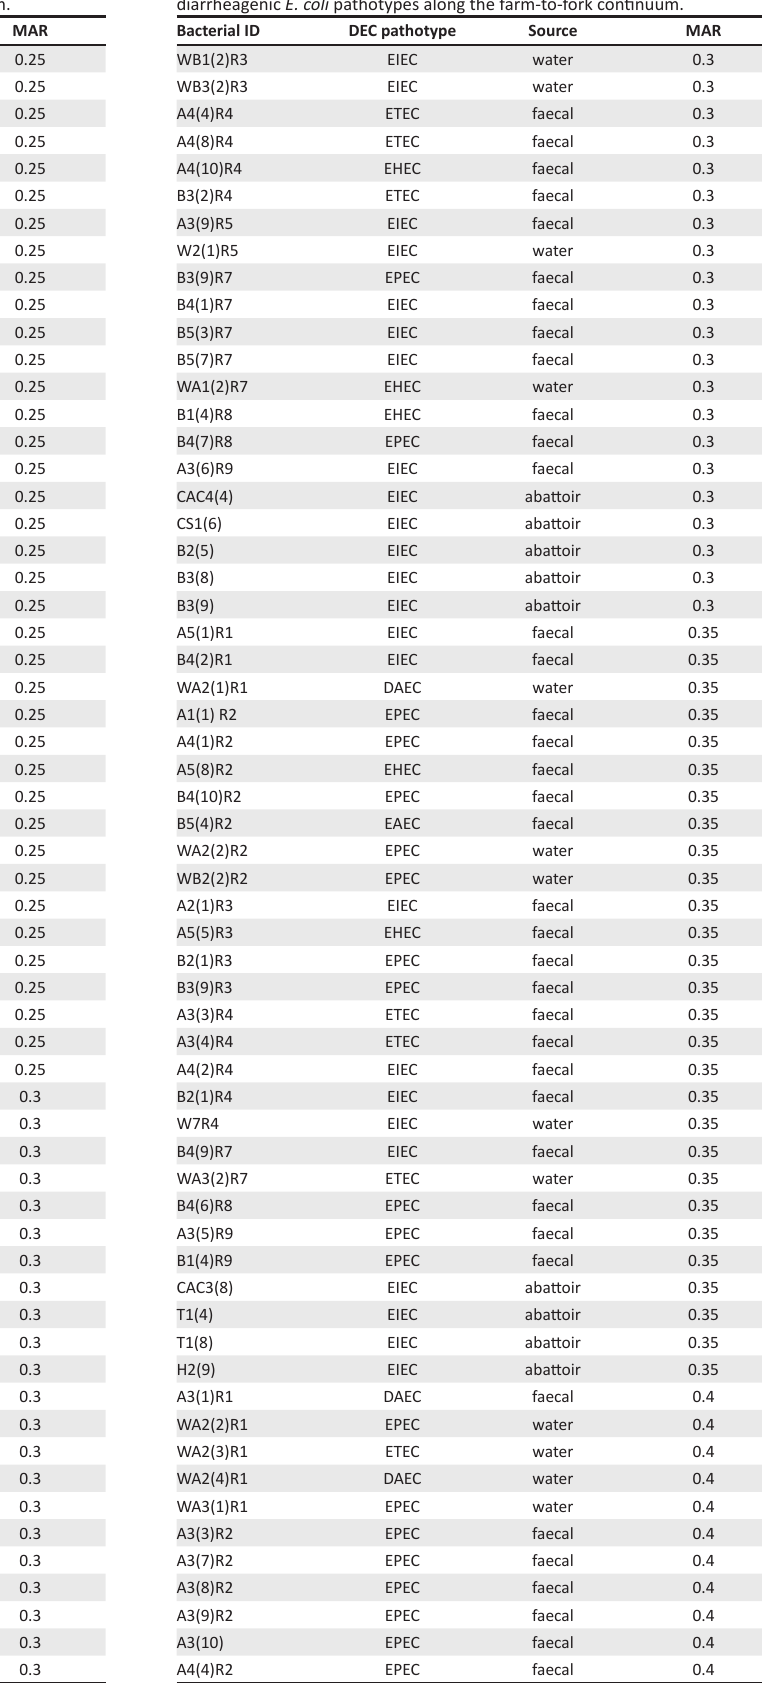
TABLE 4-A1 (Continues...): Multiple-antibiotic resistance index for all diarrheagenic E. coli pathotypes along the farm-to-fork continuum. Bacterial ID DEC